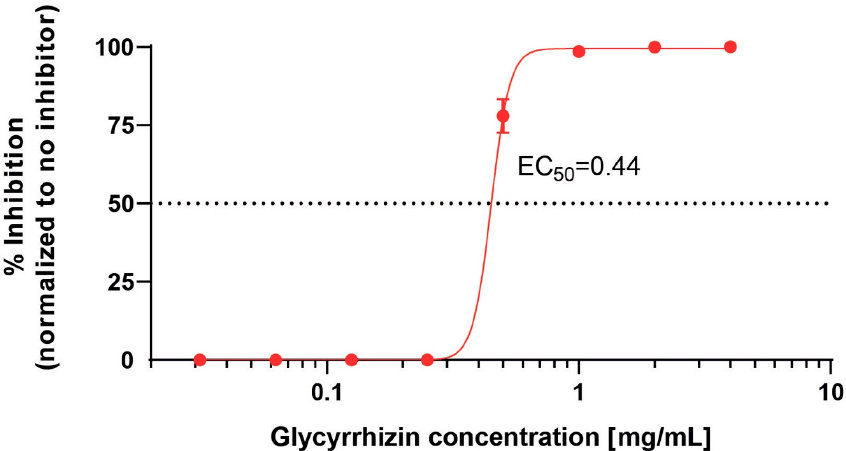
Figure 4. Dose-dependent activity of glycyrrhizin against SARS-CoV-2. Vero E6 cells were infected with 10,000 TCID 50 and treated with serial dilutions of glycyrrhizin (0.004 − 4 mg/mL), respectively. After 48 h of infection, cell culture supernatants were harvested and the viral loads were determined using endpoint dilution. The experiment was performed in technical triplicates. The EC 50 value was calculated using GraphPad Prism. Error bars display the standard error of the mean (SEM).